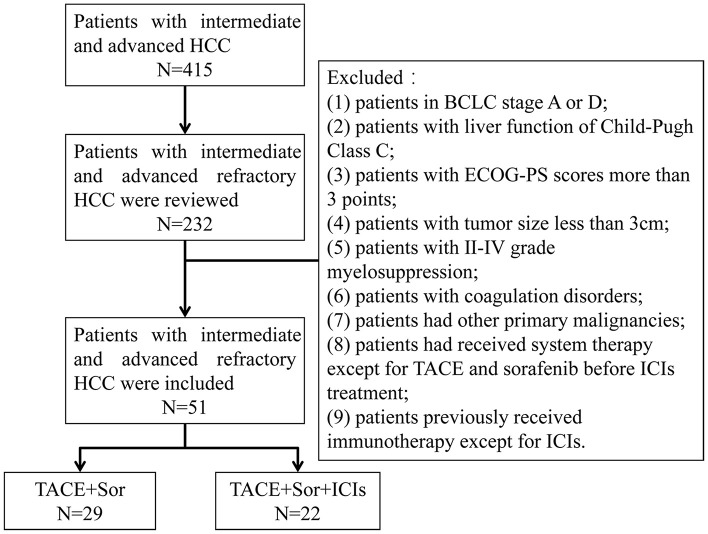
Flowchart shows patient selection. HCC, hepatocellular; BCLC, Barcelona Clinic Liver Cancer; ECOG-PS, Eastern Cooperative Oncology Group performance status; TACE, transarterial chemoembolization; Sor, sorafenib; ICIs, immune checkpoint inhibitors.